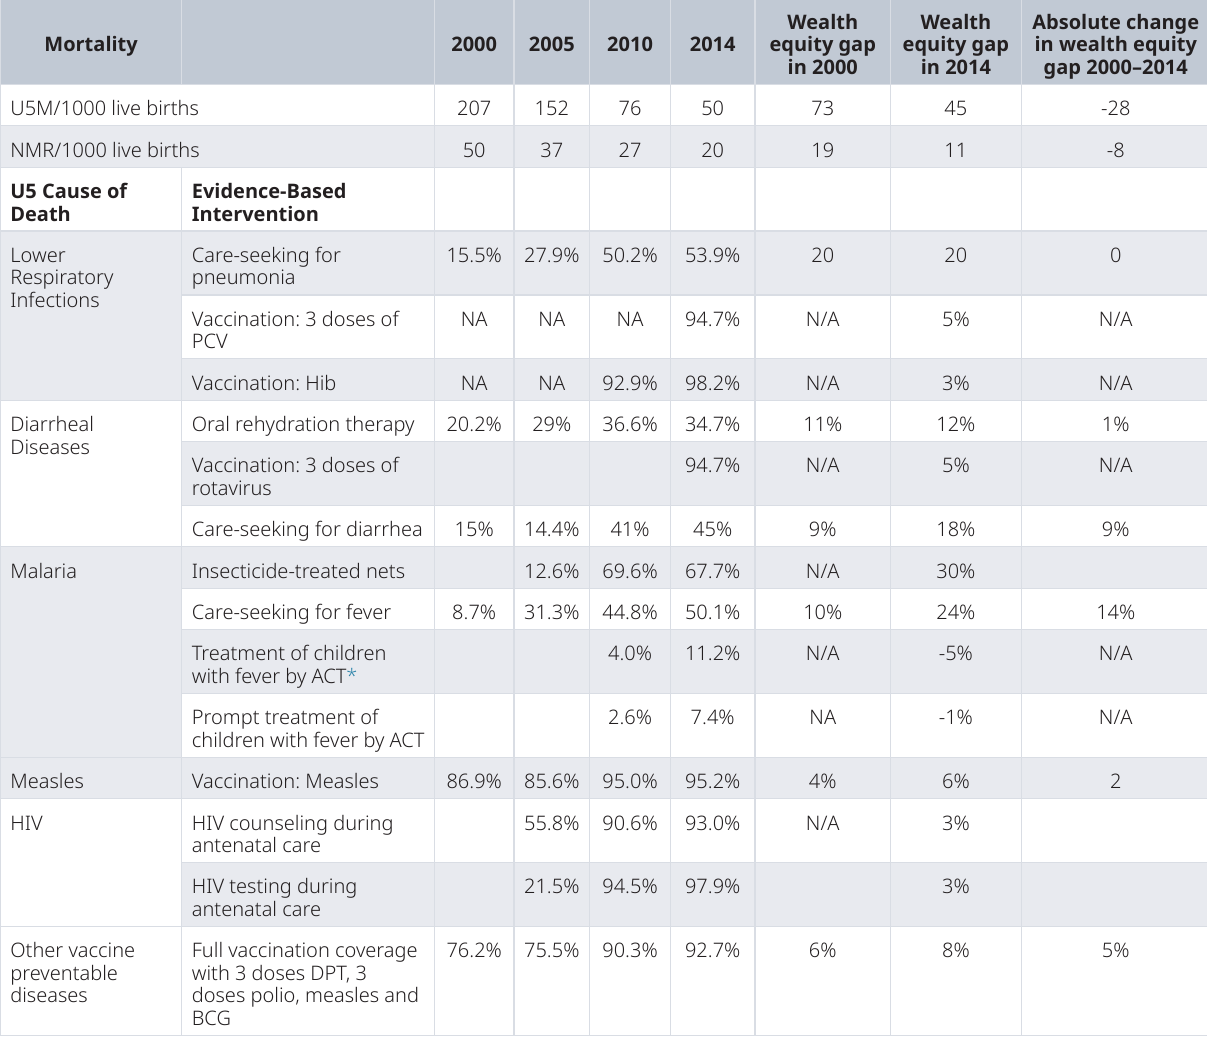
Table 1. Changes in under-5 mortality and evidence-based intervention coverage and equity gaps in Rwanda between 2000 and 2014. (Source: Rwanda DHS 2000, 2005, 2010, and 2014–15 and DHS STATcompiler).